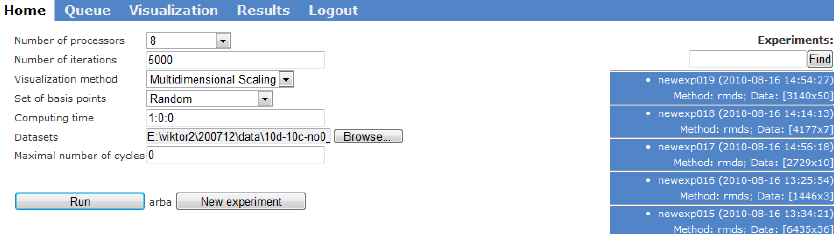
Figure 4. Client interface: visualization methods and